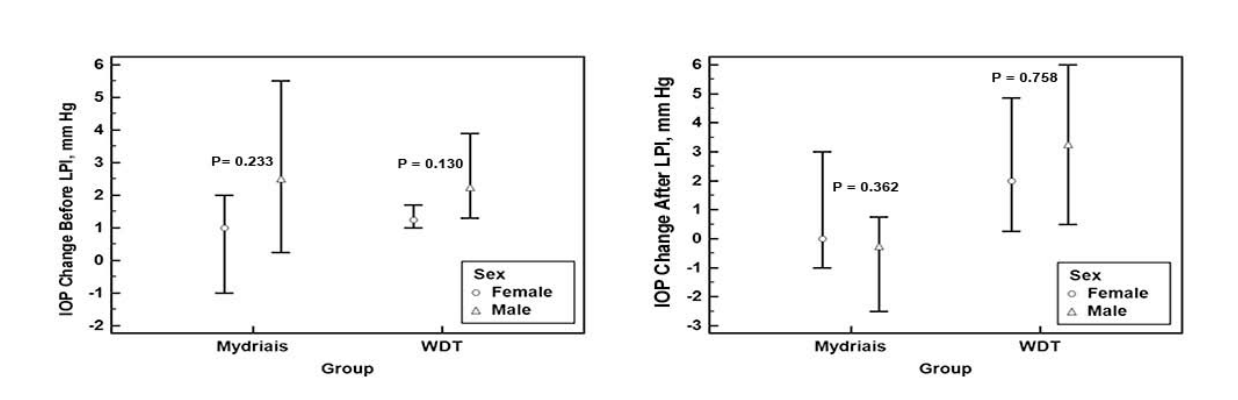
Figure 2. Effect of sex on intraocular pressure (IOP) changes after the water-drinking test (WDT) and pharmacologic mydriasis in primary angle closure suspect patients before and after laser peripheral iridotomy